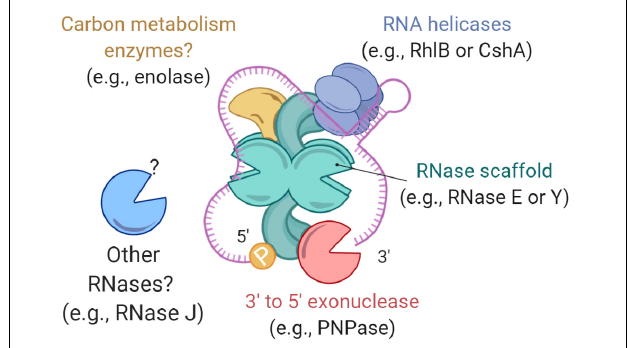
FIGURE 2 | Bacterial degradosomes. The bacterial degradosome is scaffolded by an RNase such as RNase E in E. coli and RNase Y in B. subtilis . The RNase scaffolds have catalytic domains and natively disordered scaffold domains that bind other degradosome proteins. Typical degradosome components in both gram-positive and gram-negative bacteria are RNA helicases, carbon metabolism enzymes, and other RNases.